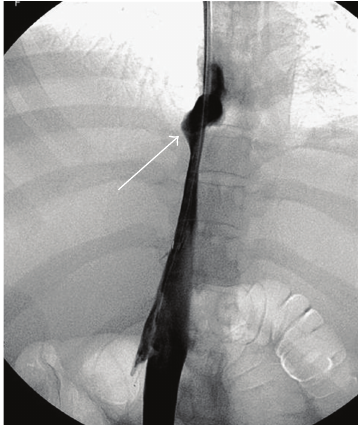
Figure 8: Cavography in a patient with Budd Chiari syndrome. Note that the right hepatic vein was almost completely occluded (arrow).